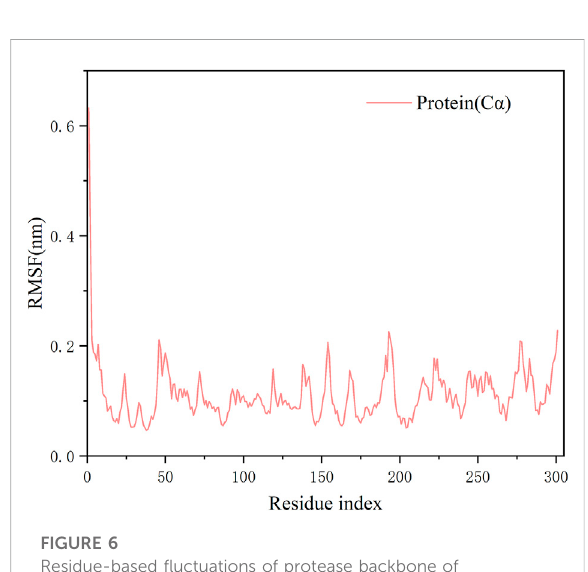
FIGURE 5 Fluctuation of RMSD values for complexes during 100 ns MD simulation.